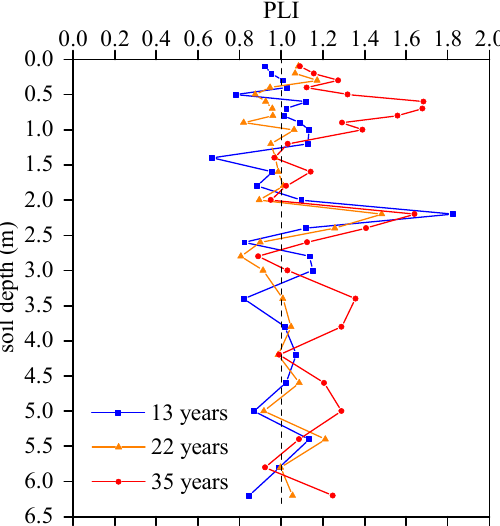
Figure 4. PLI values in soil profiles with different irrigation times. Dashed lines represent value of 1.